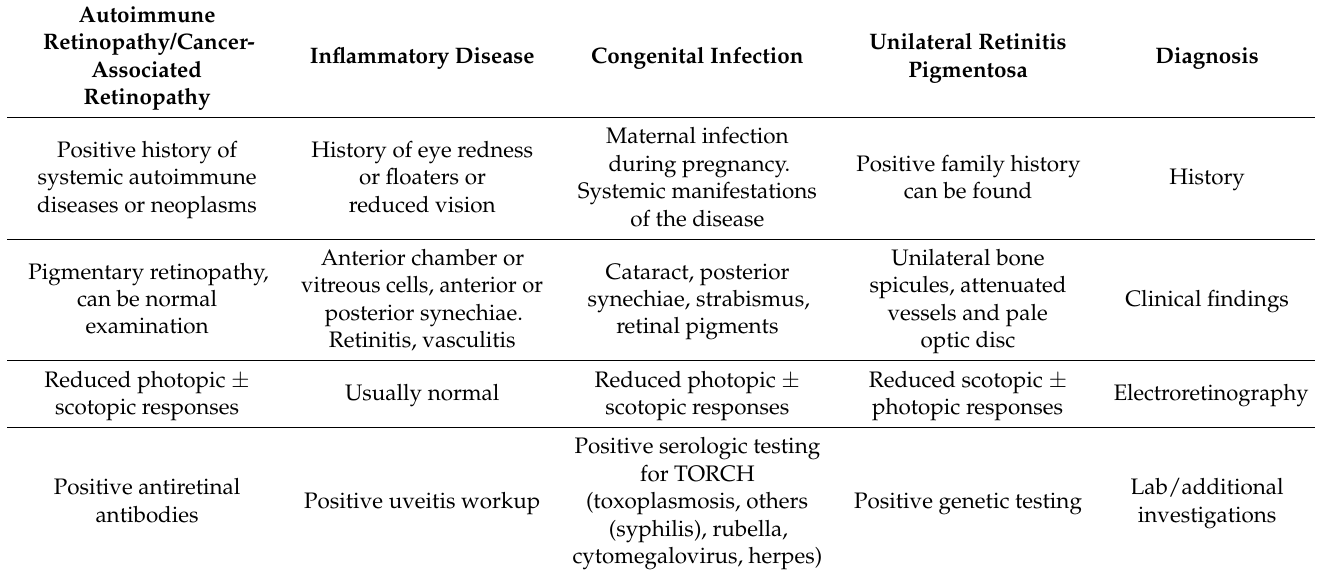
Table 1. Characteristic findings that differentiate URP from other differential